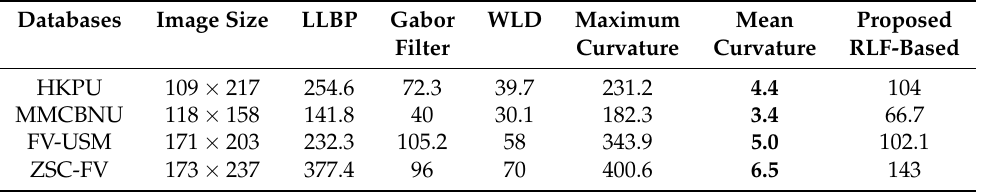
Table 5. Computational times (ms) of various methods on four finger vein